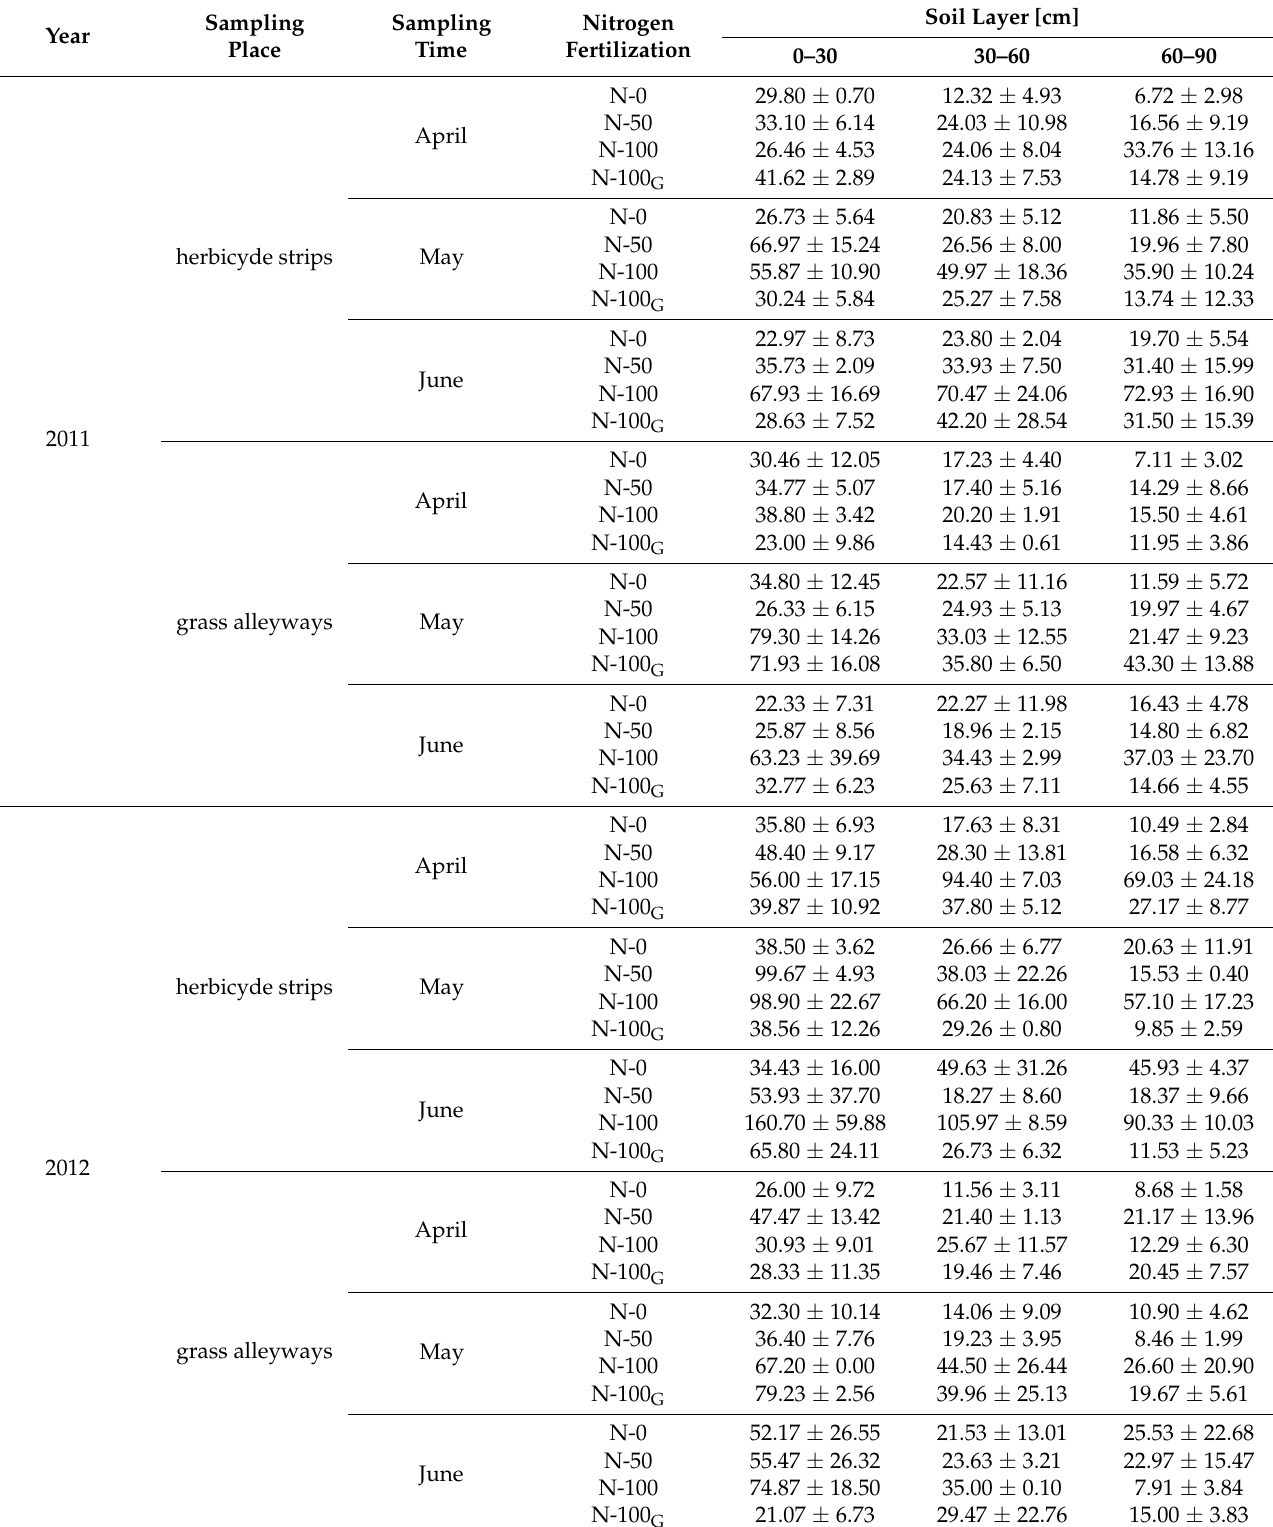
Table 1. Mineral nitrogen content in the soil (mg N · 100 g soil − 1 ; mean ± SD) in particular soil layers in relation to year, sampling place, sampling time and nitrogen